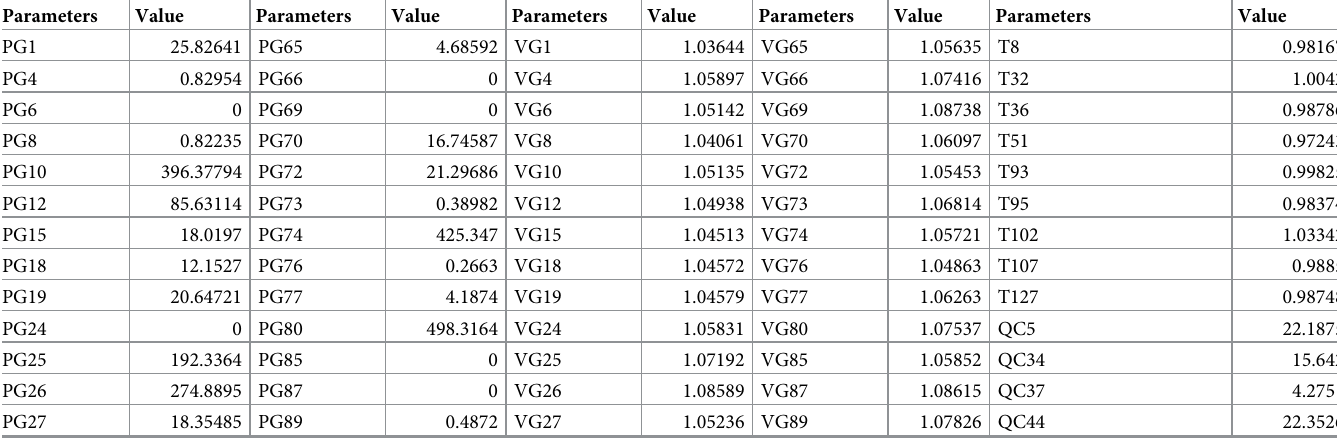
Table 7. Controlling variables of IEEE 118-bus